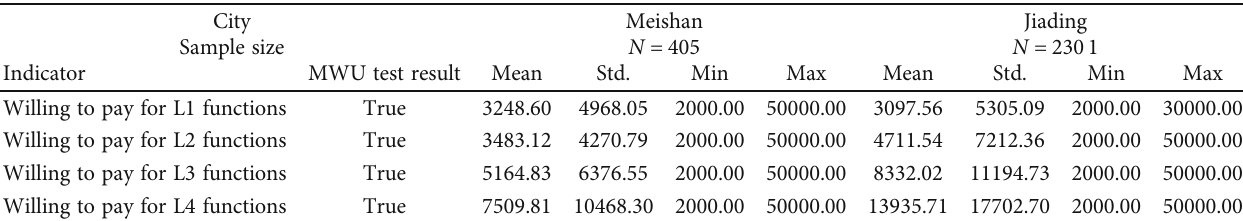
Figure 3: Willingness to choose di ff erent ADAS or autonomous driving functions. Table 6: Willingness to pay for di ff erent levels of ADAS or autonomous driving functions.